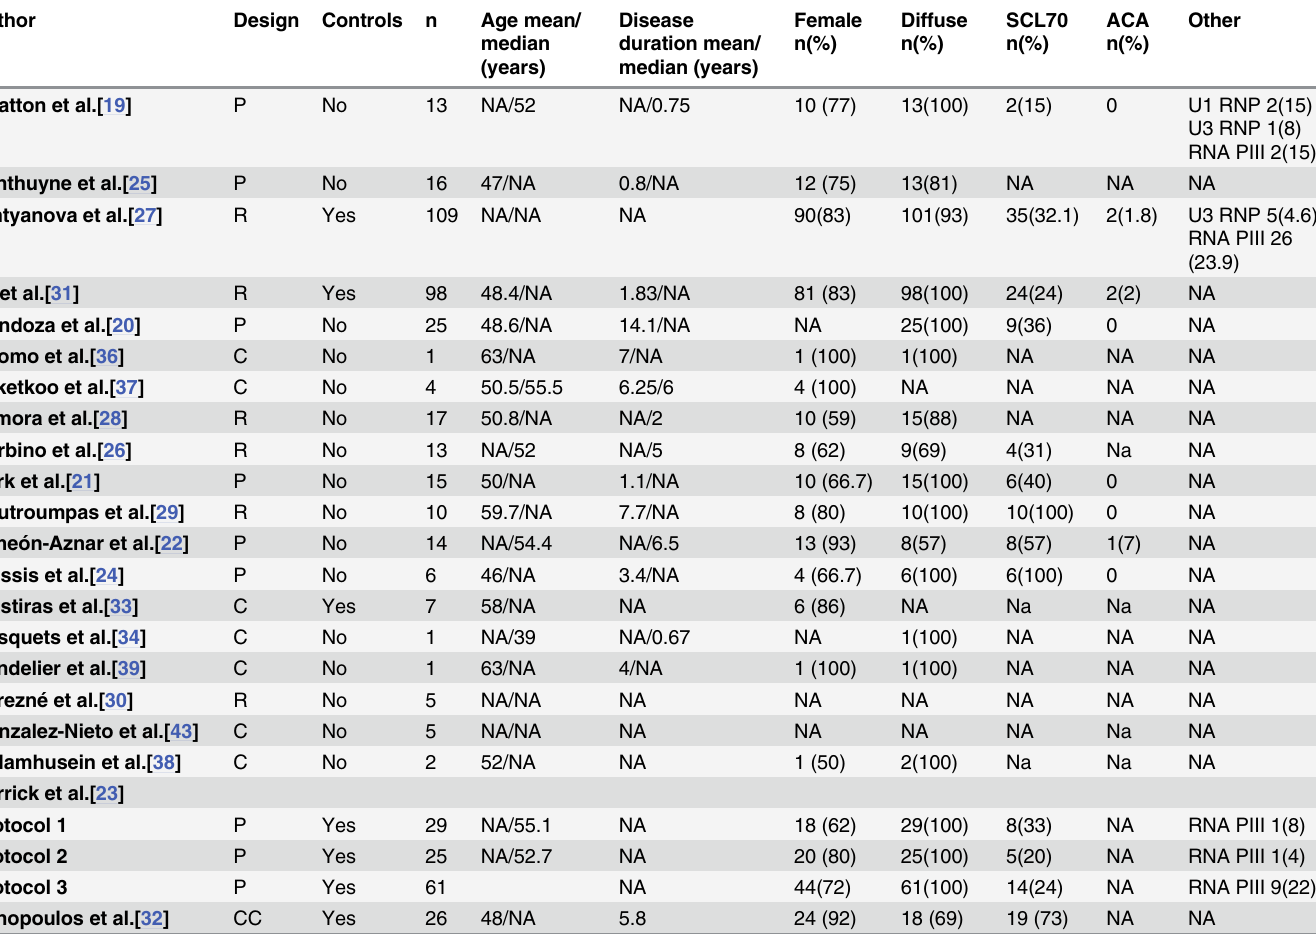
Table 1. Clinical and serological characteristics of systemic sclerosis